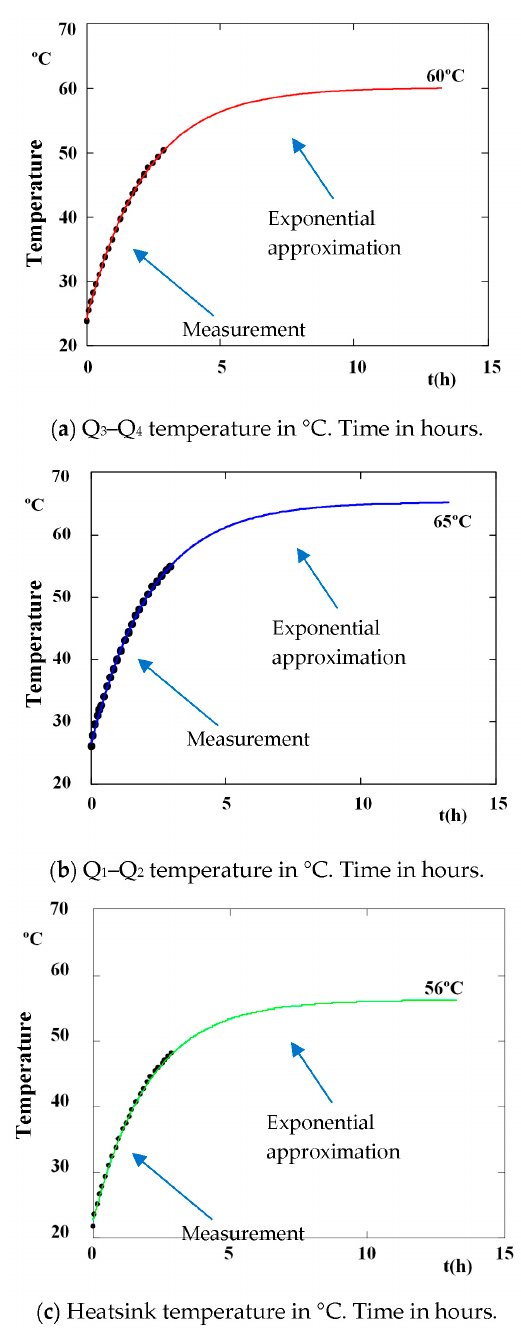
Figure 19. Measurement of temperature in °C (20 kW) for each leg and for the heatsink using MOSFET CAS300M12BM2 for a time interval of 3 h (dots). Exponential approximations are also included for the temperature ( a ) in Q 3 –Q 4 (blue), ( b ) Q 1 –Q 2 (red) and ( c ) heatsink (green). T j (Q1,Q2) or T j (Q3,Q4) are the temperatures at the junction of the switch, T H is the heatsink temperature and T A is the ambient temperature (all of them expressed in degrees Celsius). R th values have been obtained from the datasheets, the power dissipated in one leg is P Q1–Q2 ; the one dissipated in one switch is P (Q1,Q2) that dissipated in the three-phase rectifier, P Re cT ; and the power loss in the output rectifier, P Re cO . The expressions used for the calculations are (16)–(18):